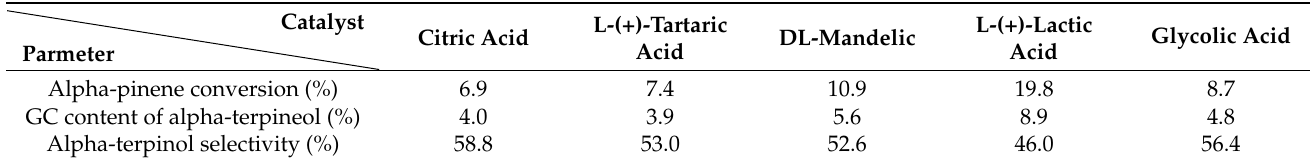
Table 3. Effect of phosphoric acid on the hydration of alpha-pinene without acetic acid as the auxiliary agent.